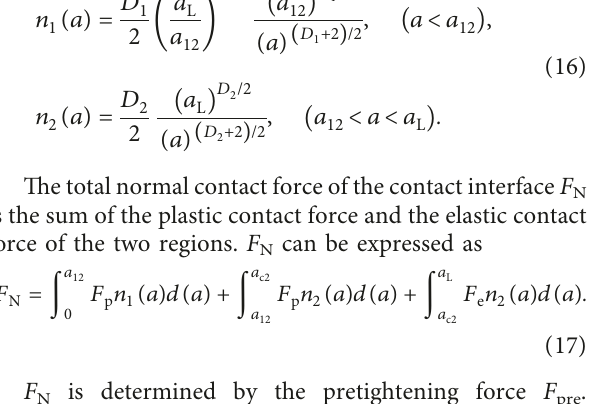
Figure 7: Schematic for the contact